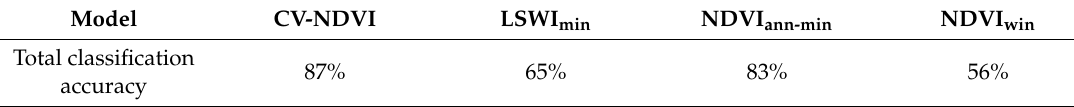
Table 6. Field sampling accuracy